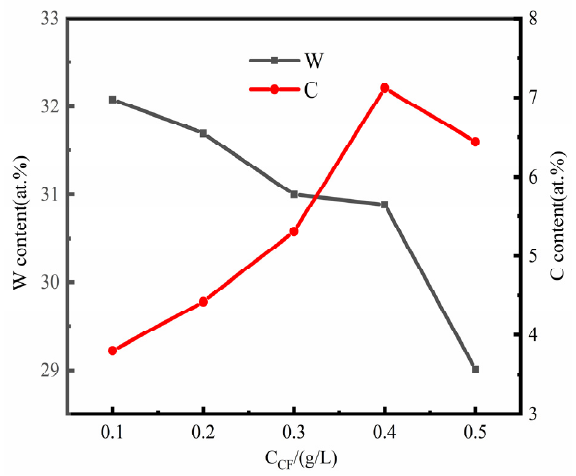
Figure 3. Effect of CF concentration on tungsten content and carbon content in Ni-W-CF composite coating.